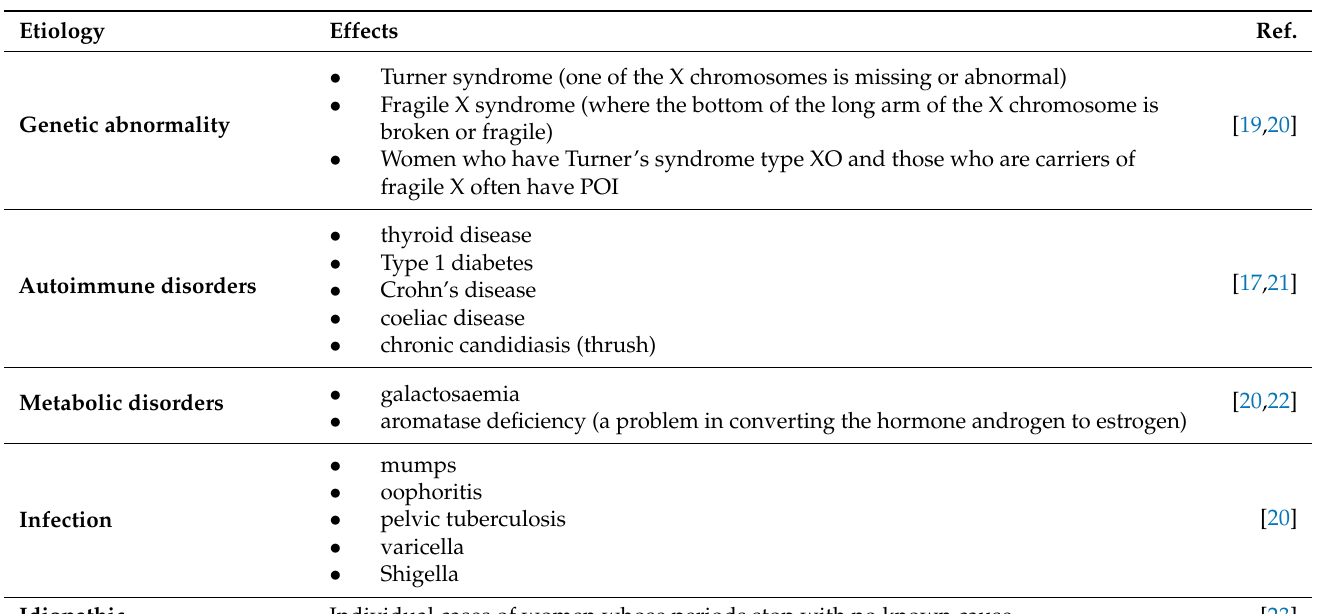
Table 2. Causes of early